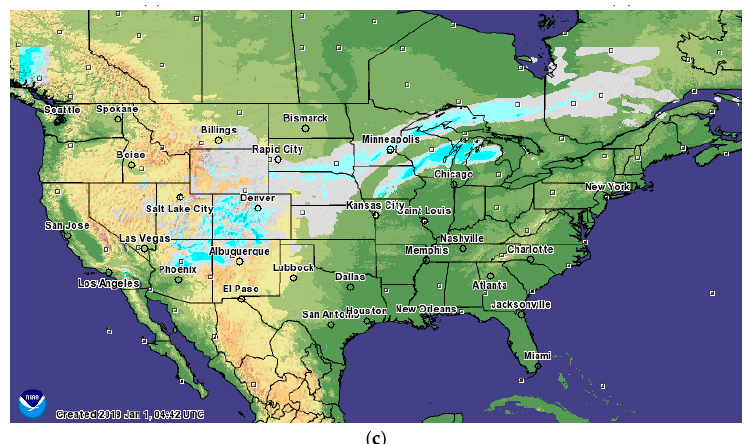
Figure 7. ( a ) Retrieved GMI-based Liquid Water Snowfall Rate in mm hr − 1 on 31 December 2018 20:36 Zulu time, ( b ) near coincident NEXRAD base reflectivity in dbZ, and ( c ) near coincident hourly snowfall accumulation from NOAA SNODAS.